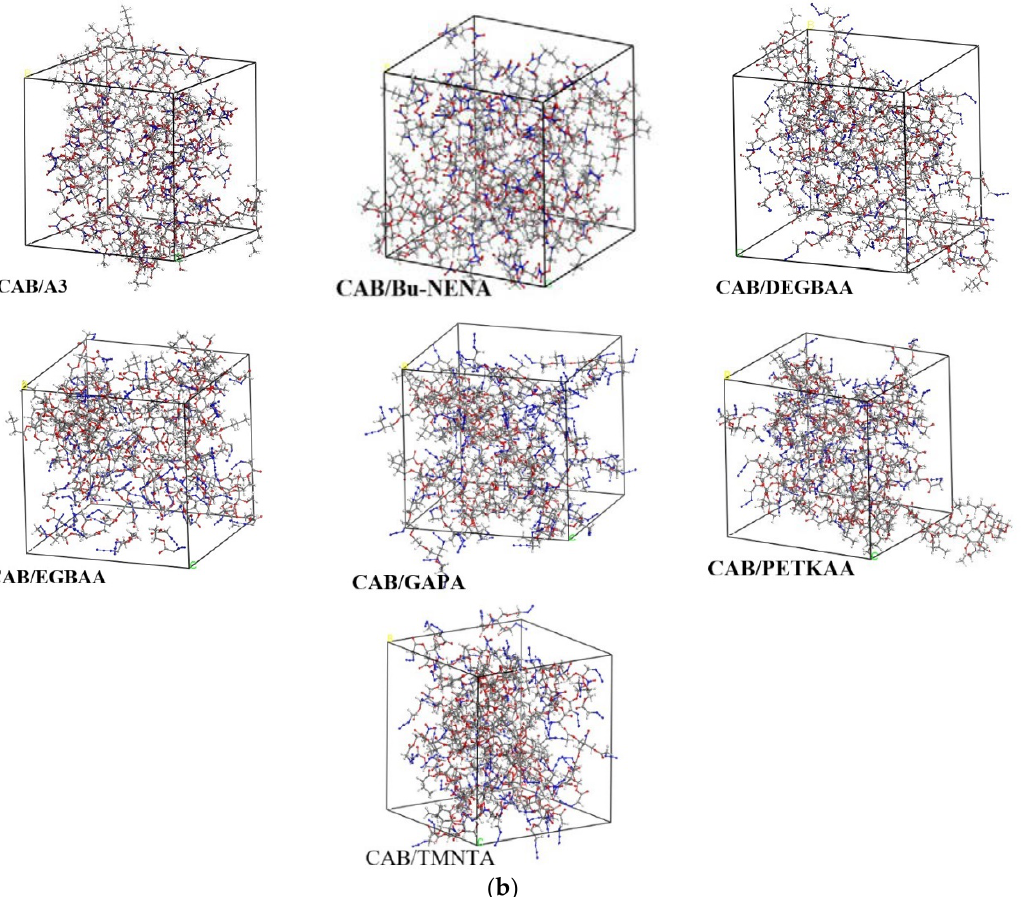
Figure 1. Molecular structures ( a ) and amorphous models ( b ) of CAB/plasticizer systems. CAB = cellulose acetate butyrate.